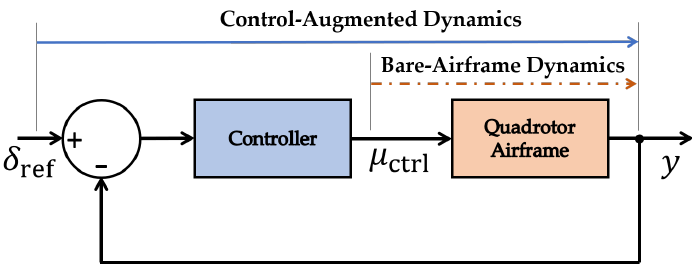
Figure 1. A schematic of input-output signals for closed-loop and open-loop mappings.